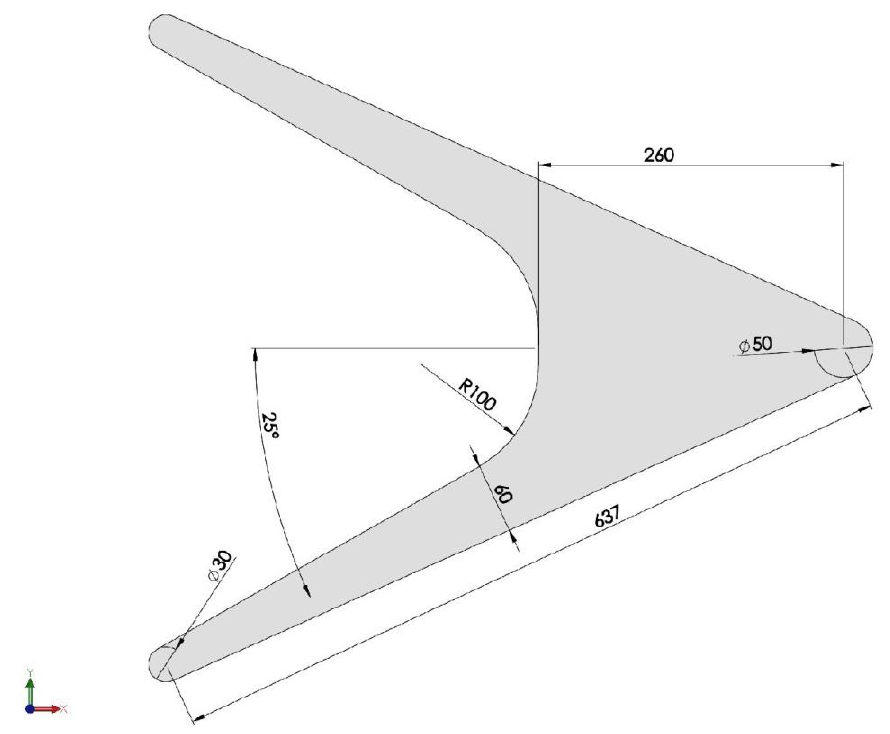
Figure 12. Delta VLFS with stern radius R 3 = 15 m (30 m stern diameter).